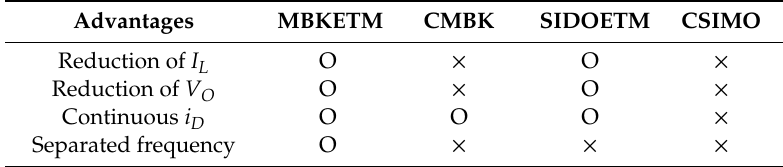
Table 6. Summary table with multi-phase buck and single-inductor dual-output (SIDO) buck type converters.